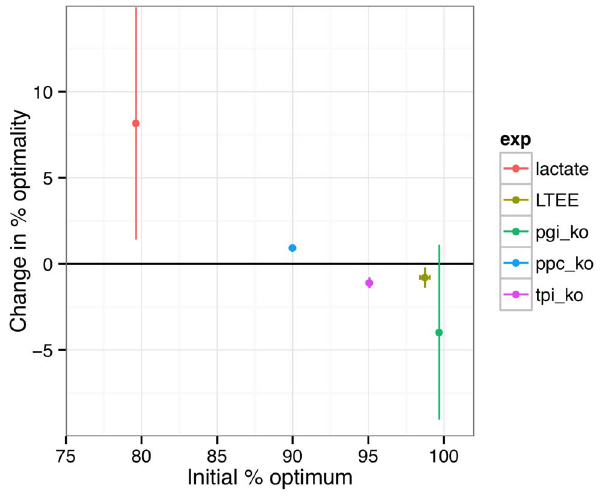
Figure 6. Evolutionary change in % optimality versus initial % optimality of the ancestor across data sets for BM/S. Error bars represent standard errors between evolved populations.